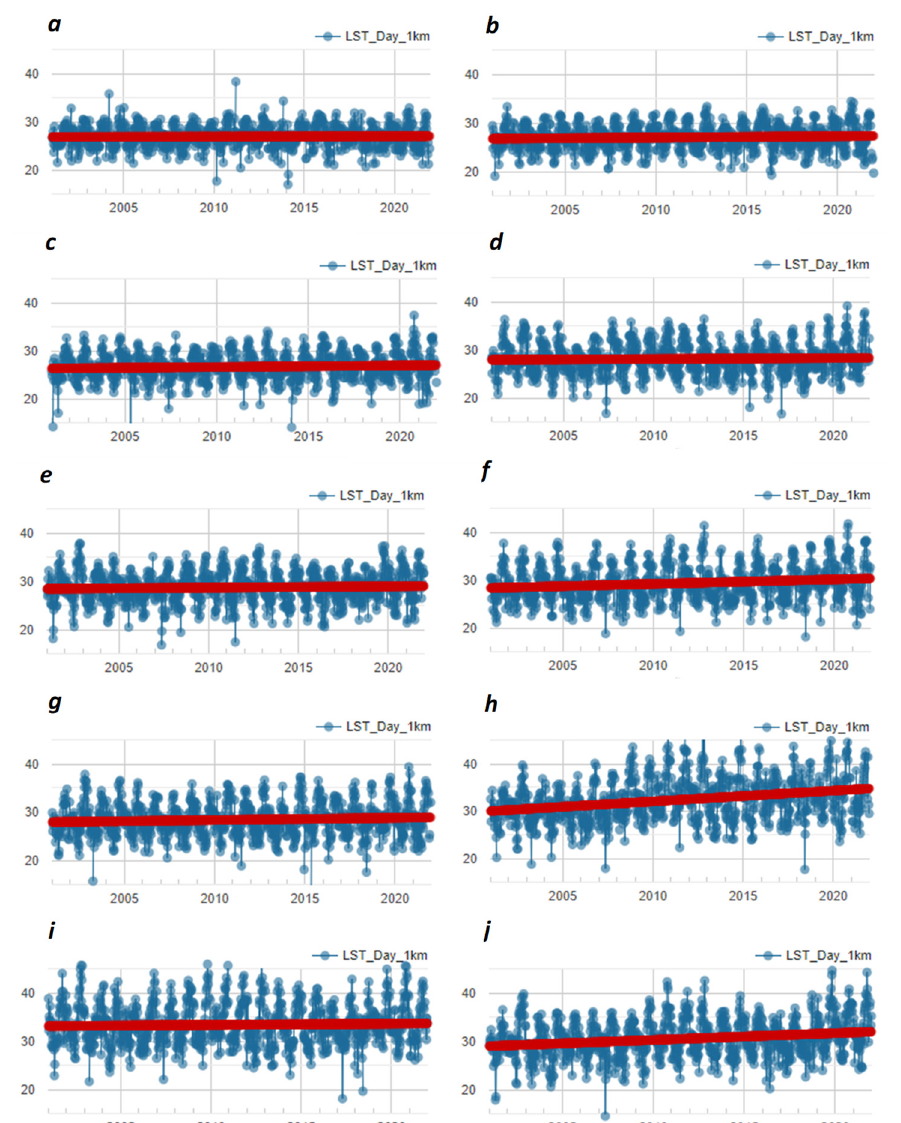
Figure 6. Time series trends in daytime LST (°C) in forested and deforested areas in the Chiquitania region (2001–2021). The red line represents the trend line of the data points. Sites with intact forest: ( a ) Noel Kempff, ( b ) Bajo Paraguá, ( c ) Monteverde, ( d ) San Rafael, and ( e ) Tucabaca. Sites with deforestation: ( f ) San Ignacio, ( g ) Concepción, ( h ) El Cerro/California, ( i ) Nueva Esperanza, and ( j ) Santa Ana/Buena Vista. Table 3. Daytime LST trends (°C) for the ten study sites in the Chiquitania region. n—MODIS data series, p—statistical significance < 0.05 (highlighted in bold), Z—nonparametric Mann–Kendall test. Sites Coverage n p Z Noel Kempff